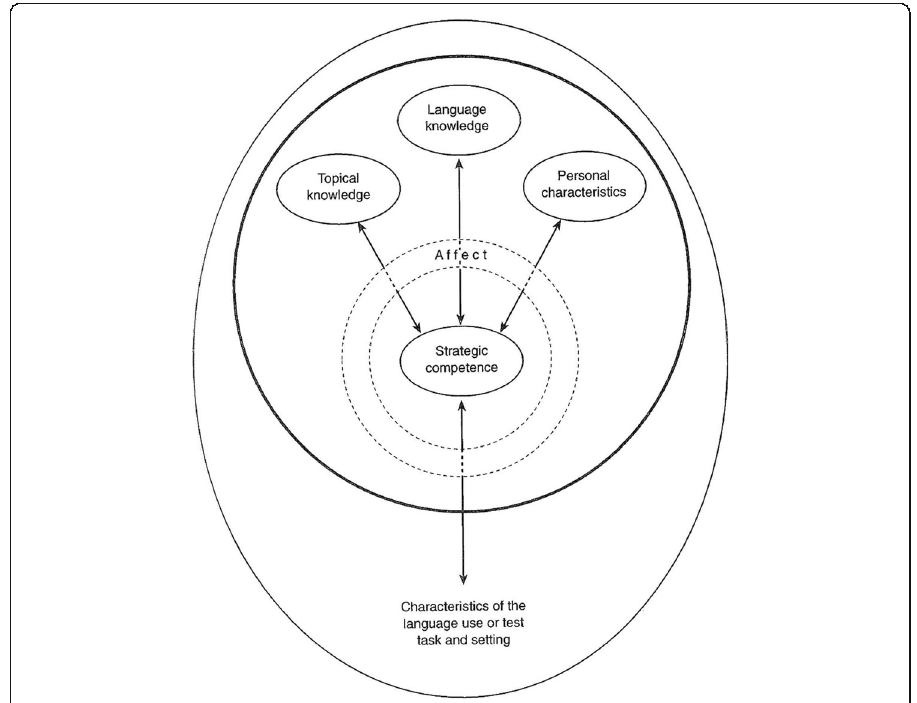
Fig. 7 Test takers ’ competence and language use or testing (Bachman and Palmer 1996, p.